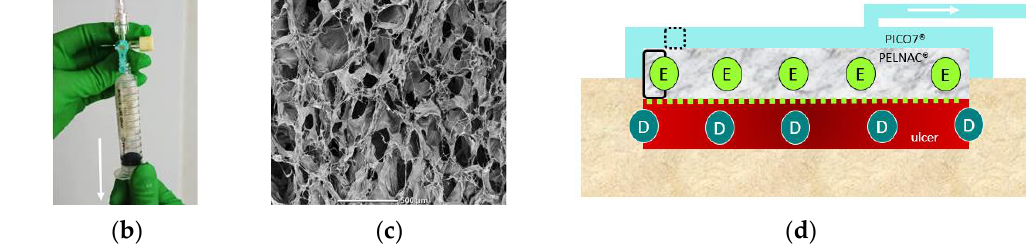
Figure 3. Infusion of micrografts into artificial dermis & schematic diagram of the wound site. ( a ) Micrograft suspension derived from the epidermal layer (dashed arrow) was placed inside a syringe with artificial dermis (PELNAC G plus ® ) (solid arrow) for infusion. The epidermal micrograft suspension (dashed arrow) was turbid and slightly viscous. ( b ) The syringe plunger is pulled in the arrow direction to apply negative pressure of approximately 0.5 atm in order to infuse the artificial dermis (PELNAC G plus ® ) with epidermal micrograft suspension. ( c ) SEM (Scanning Electron Microscope) image of the collagen sponge layer in the artificial dermis (PELNAC G plus ® ). ( d ) Schematic diagram of the ulcer immediately after the treatment: the dermal-subdermal micrograft (D) suspension is sub-dermally injected in the ulcer and around the ulcer margin for transplant. The artificial dermis infused with epidermal micrograft (E) was applied to the wound. Immediately thereafter, NPWT was performed. Solid line area shows the sample section of the artificial dermis, and the dashed line area represents the sample section of the dressing.